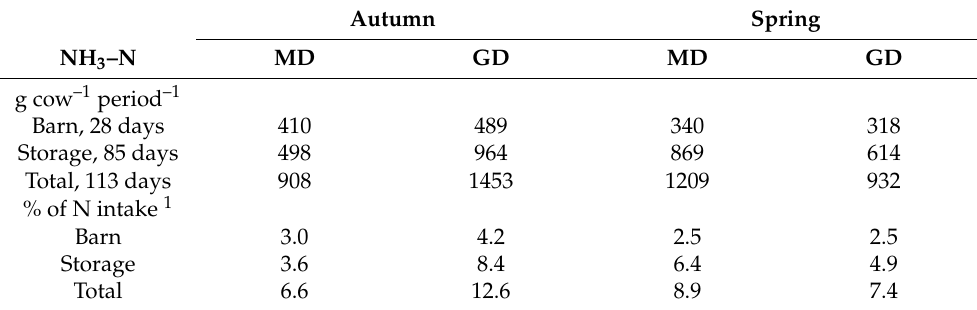
Table 4. Ammonia (NH 3 –N) cumulative emissions from straw-based deep litter produced by dairy cows fed with a maize-silage-based diet (MD) or a grass-based diet (GD) in autumn or